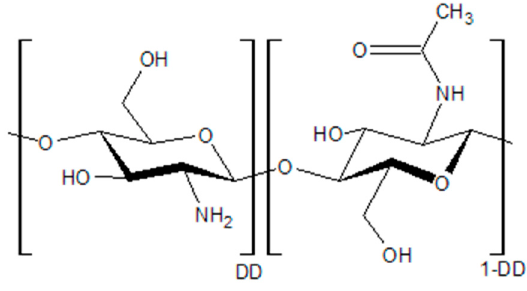
Figure 1. The glucosamine and acetyl glucosamine units that comprise chitosan and chitin. When the degree of deacetylation (DD) is greater than 0.6, the polymer is considered chitosan.